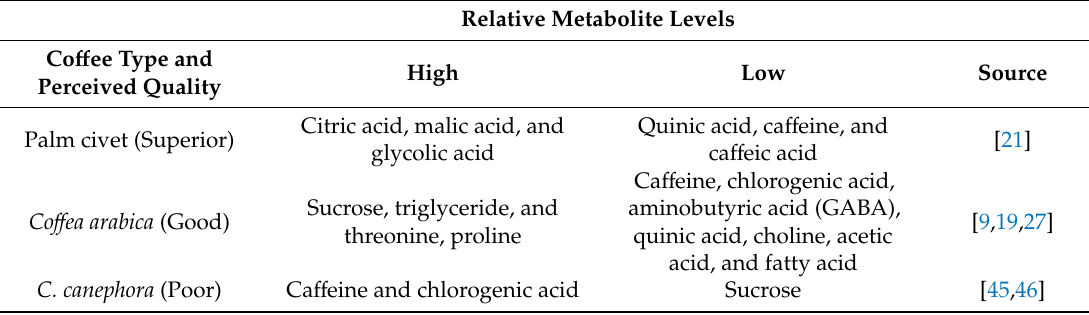
Table 4. Relative levels of metabolites that contribute to co ff ee quality based on published